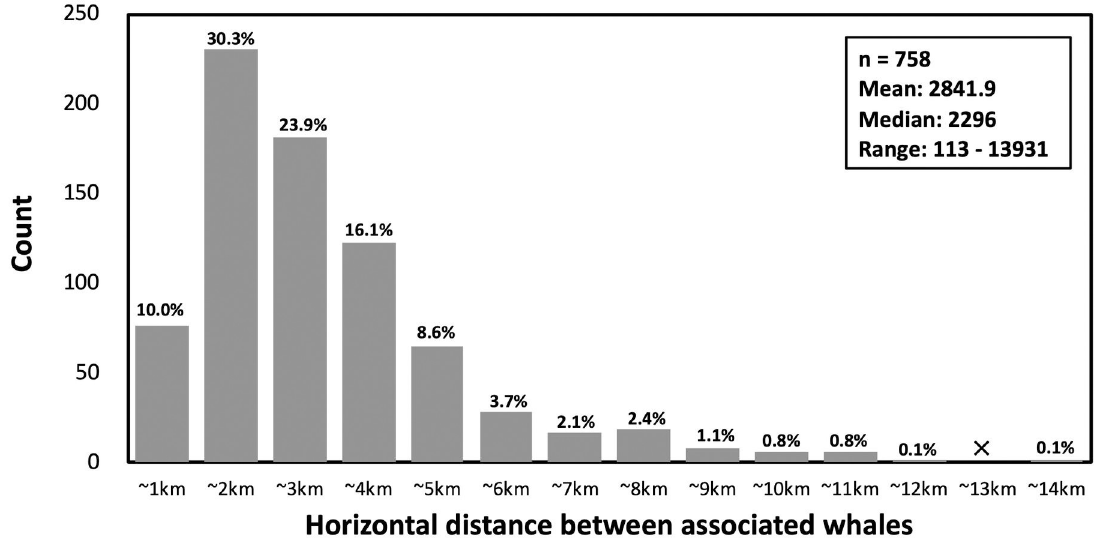
Fig 2. Distribution of horizontal distance between locations of observations of associating whales (identified within 1 hour) from the research